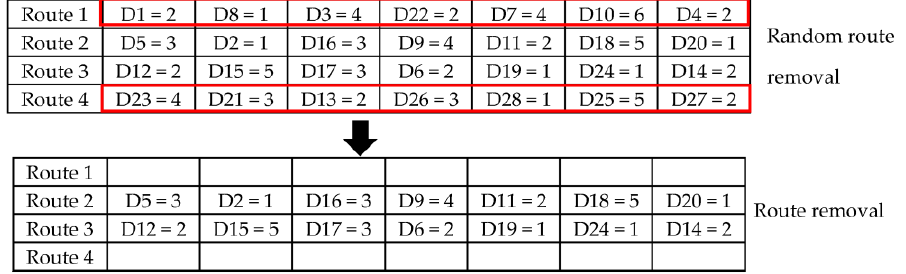
Figure 3. Two routes removal example for K-route removal.